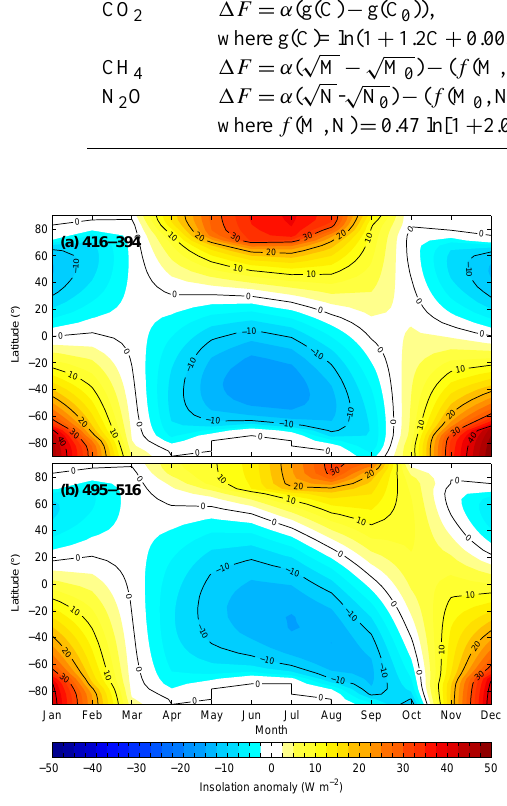
Figure 7. Differences in the seasonal and latitudinal distribution of insolation for (a) 416–394ka and (b)